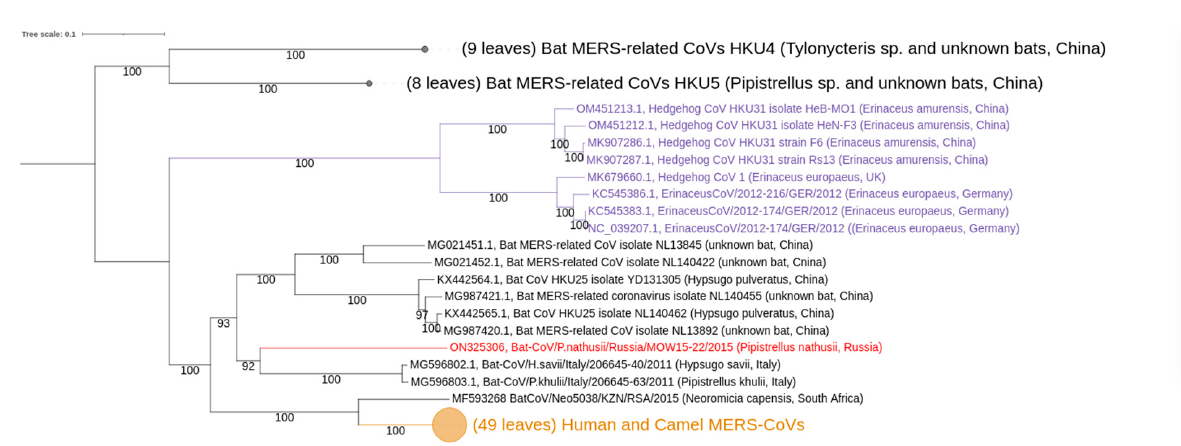
Figure 3. Phylogenetic trees of Merbecovirus genomes (from complete genomes only). The phylogenetic tree was constructed from 84 complete genome sequences, excluding 5 ′ - and 3 ′ -ends (29,757–30,331 bp). Numbers show bootstrap values. Best-fit model of substitution according to BIC: GTR + F + I + G4. The virus described in this study is labeled in red bold.